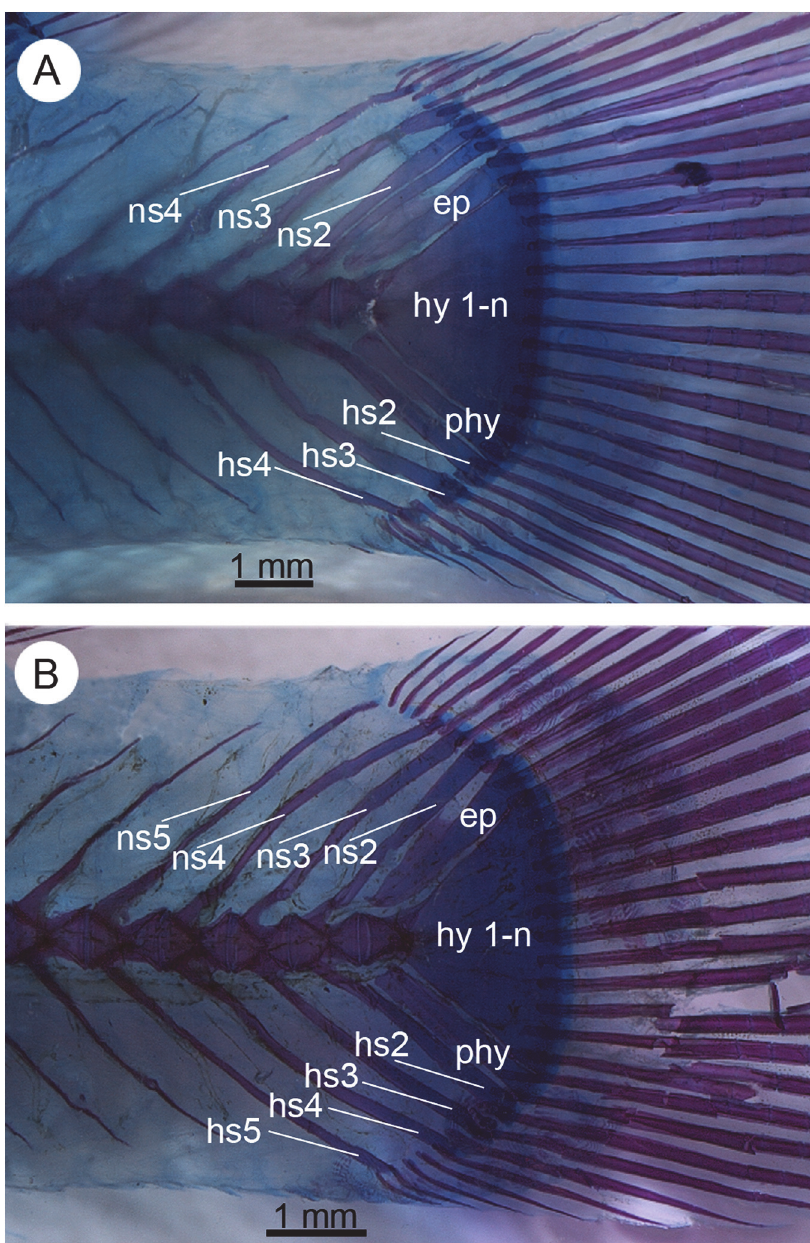
Fig 13. Intraspecific variation in the number of preural vertebrae in Nothobranchius orthonotus (MRAC A4-039-P-0133-0134). A Four preural vertebrae; B five preural vertebrae © Royal Museum for Central Africa Tervuren (Belgium). Abbreviations: ep, epural; hs2 – 5, haemal spine of preural vertebrae 2 – 5; hy 1-n, hypural plates 1 – n; ns2 – 5, neural spine of preural vertebrae 2 – 5; phy,